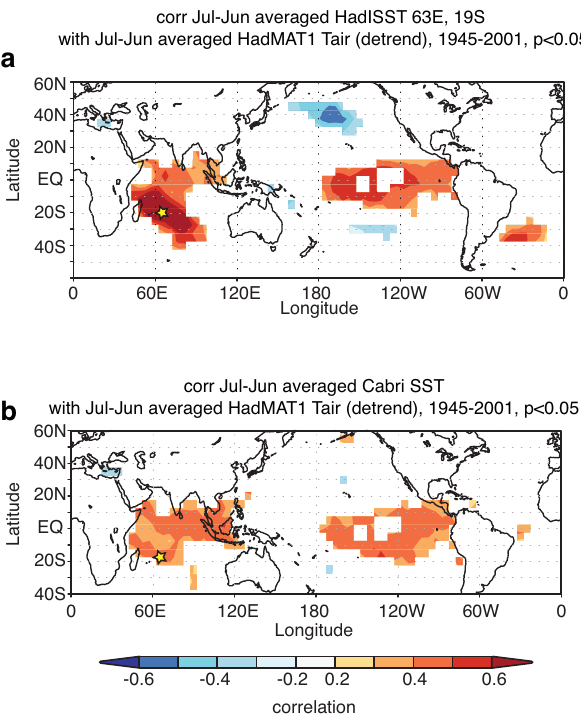
Figure A4. Spatial correlations of mean annual HadMAT1 air temperature anomalies between 1945 and 2001 relative to 1961–1990 with (a) HadISST for Rodrigues, and (b) Cabri SST. Only correlations with p <0.05 are coloured. Computed at KNMI Climate Explorer (van Oldenborgh and Burgers, 2005). Y axis: latitude, X axis: longitude.